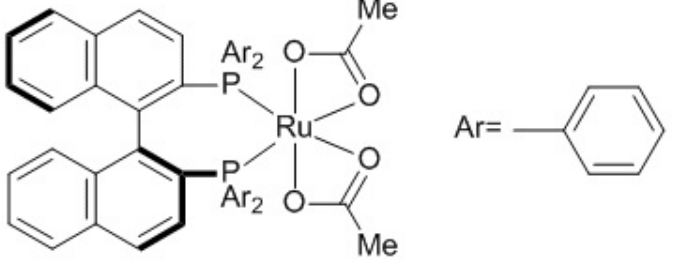
Figure 12. Ruthenium catalyst from S-BINAP used for the synthesis of S-ibuprofen.